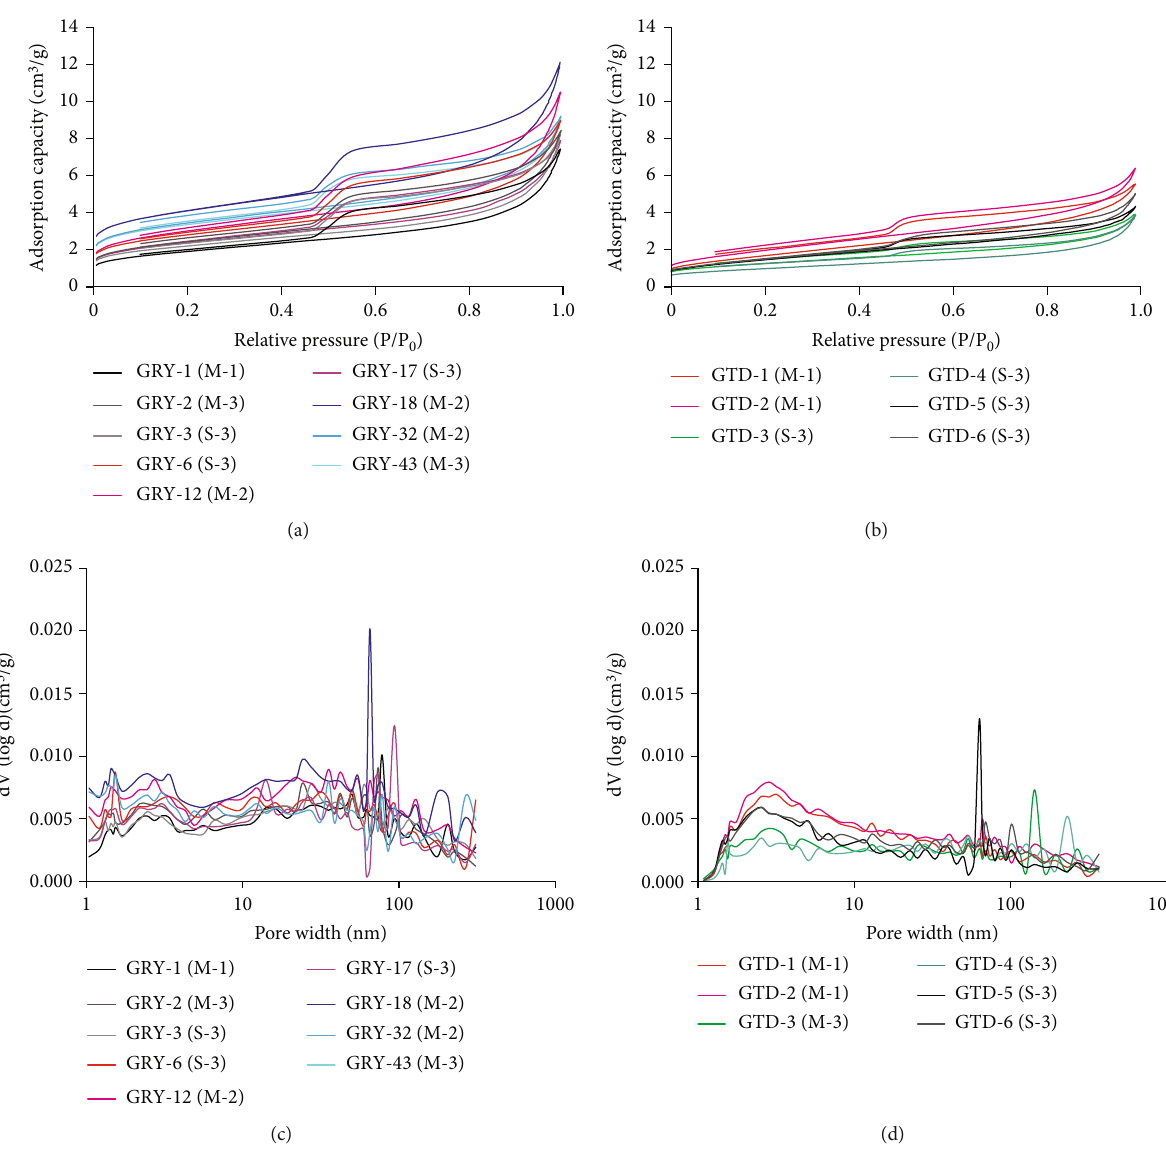
Figure 6: (a) N adsorption curve of Carboniferous shale samples in well GRY1; (b) N 2 GTD1; (c) N pore diameter distribution curve of Carboniferous shale samples in well GRY1; (d) N 2 Devonian shale samples in well